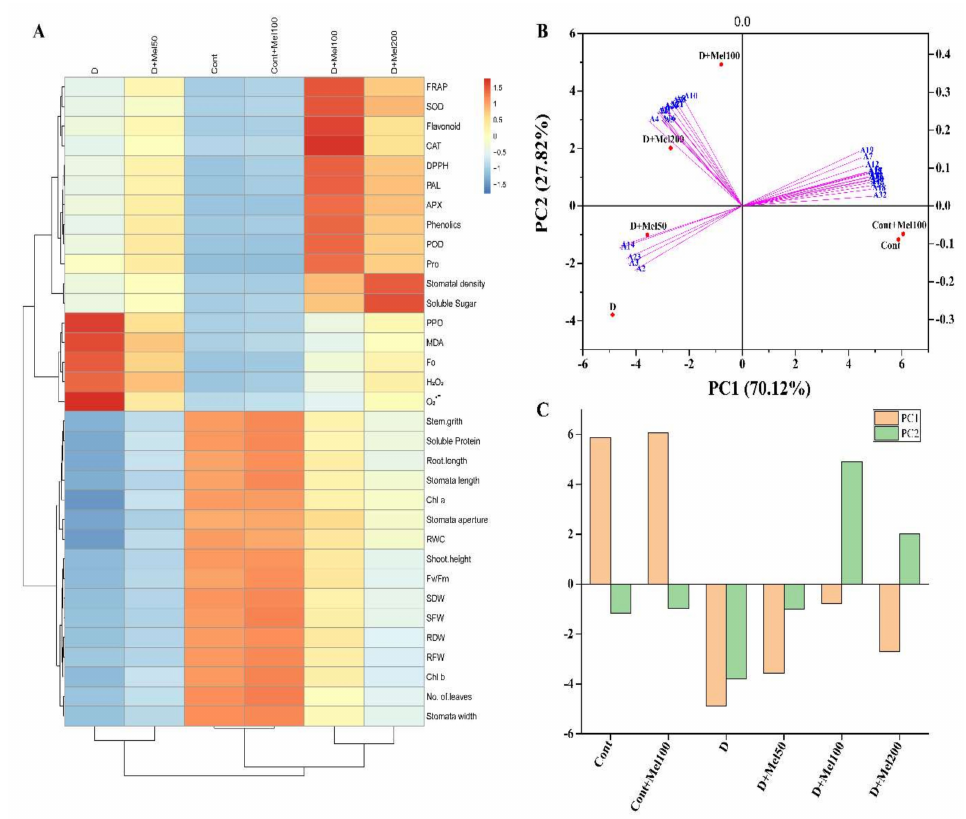
Figure 8. The e ff ects of exogenous melatonin were evaluated by hierarchical clustering analysis using plant growth parameters, Chl pigments, photosynthesis rate, stomata properties, RWC, ROS, MDA, di ff erent enzymatic and non-enzymatic antioxidants, osmoregulate substances, and total antioxidant. ( A ). Principal component analysis (PCA) was performed between drought stress and melatonin treatments, with di ff erent morphological and physiological trials ( B ). Principal component analysis scoring plot among all treatment ( C ). Here, the red and blue colors indicate increase and decrease in the values of di ff erent parameters, Cont: Control, 80% field capacity (FC); D: Drought, 20%